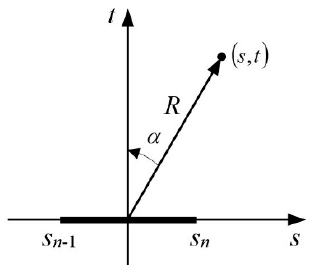
Figure 7. Element of discretization of lines on which the potential density function is determined (see dashed line in Figure 6) and the sense of local coordinates s, t.